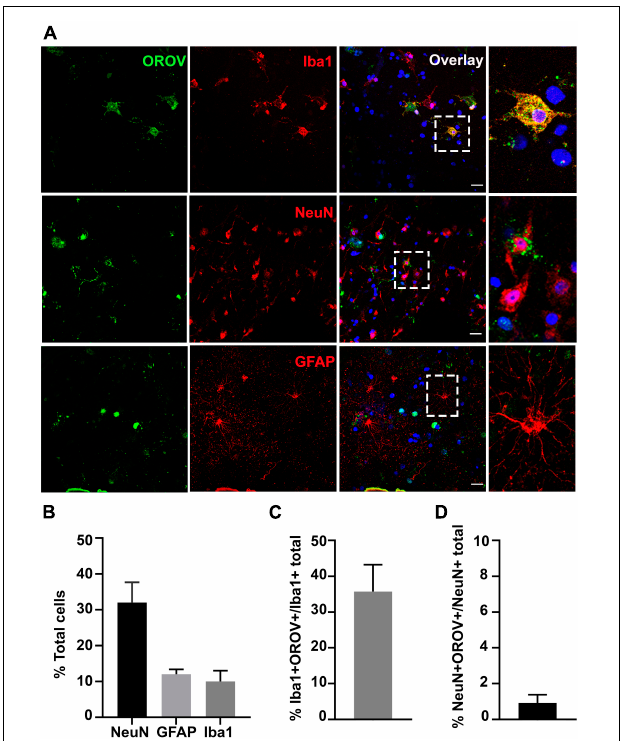
FIGURE 3 | Oropouche virus targets microglia and neurons in adult human brain slices. (A) Representative confocal images of immunofluorescence labeling for OROV (green) and Iba1, NeuN or GFAP (red) in cultured slices 48 hpi. Scale bar = 20 µ m. (B) Percentages of Iba1, NeuN and GFAP positive cells among total cells. (C,D) Percentage of OROV-positive cells among cells positive for Iba1 or NeuN, respectively. Results are shown as mean ± SD ( n = 2–5